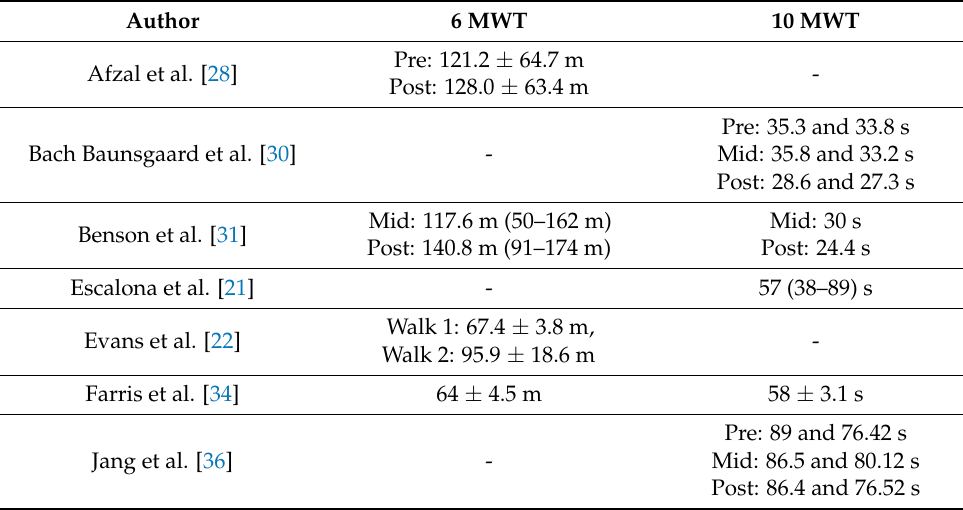
Table 4. Mean 6 MWT (m) and 10 MWT (s or m · s − 1 )